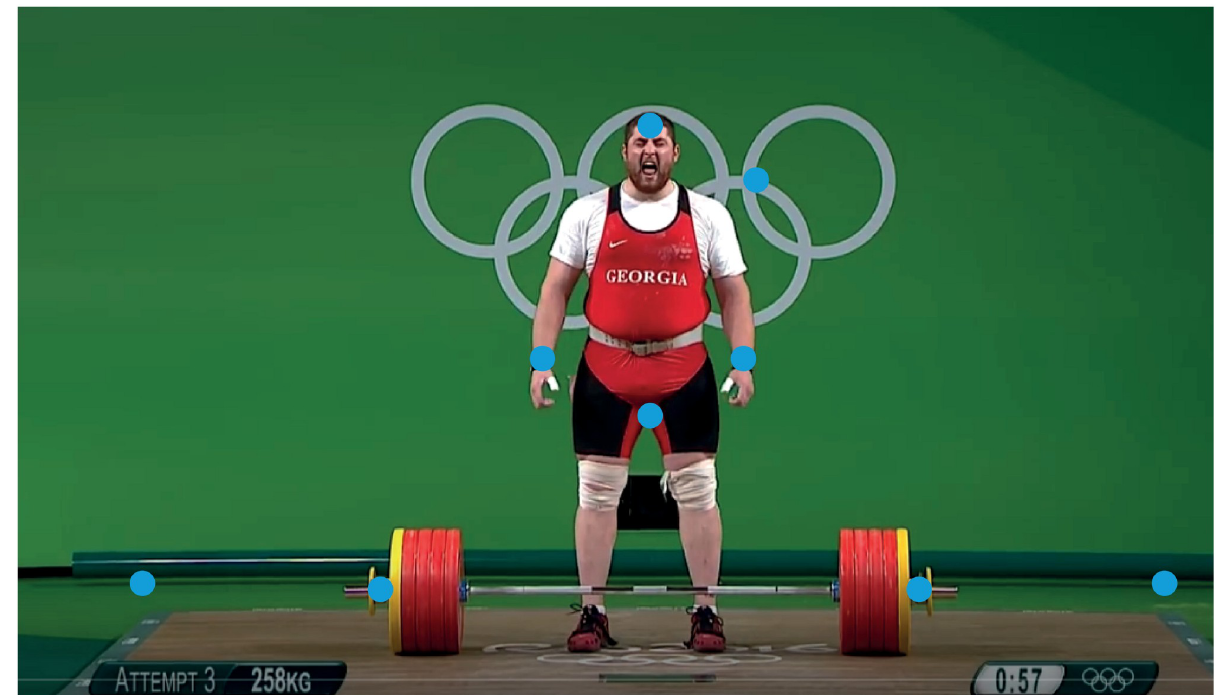
Fig 31. Lasha Talakhadze in men’s weightlifting. The video tracking was based on 9 points of interest represented by blue markers, including 3 fixed points of calibration, 2 points on the barbell and 4 anatomical points (forehead, crotch, wrist on the left, wrist on the right). Source of the original video: